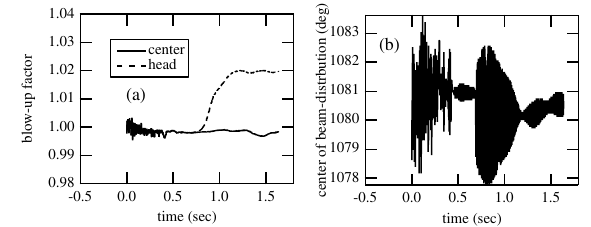
FIG. 14. (a) Blowup factor of emittance for the center and head of the rf bunch seen in Figs. 12. (b) Center of the beam distribution for the head bunch in the (cid:23) direction.